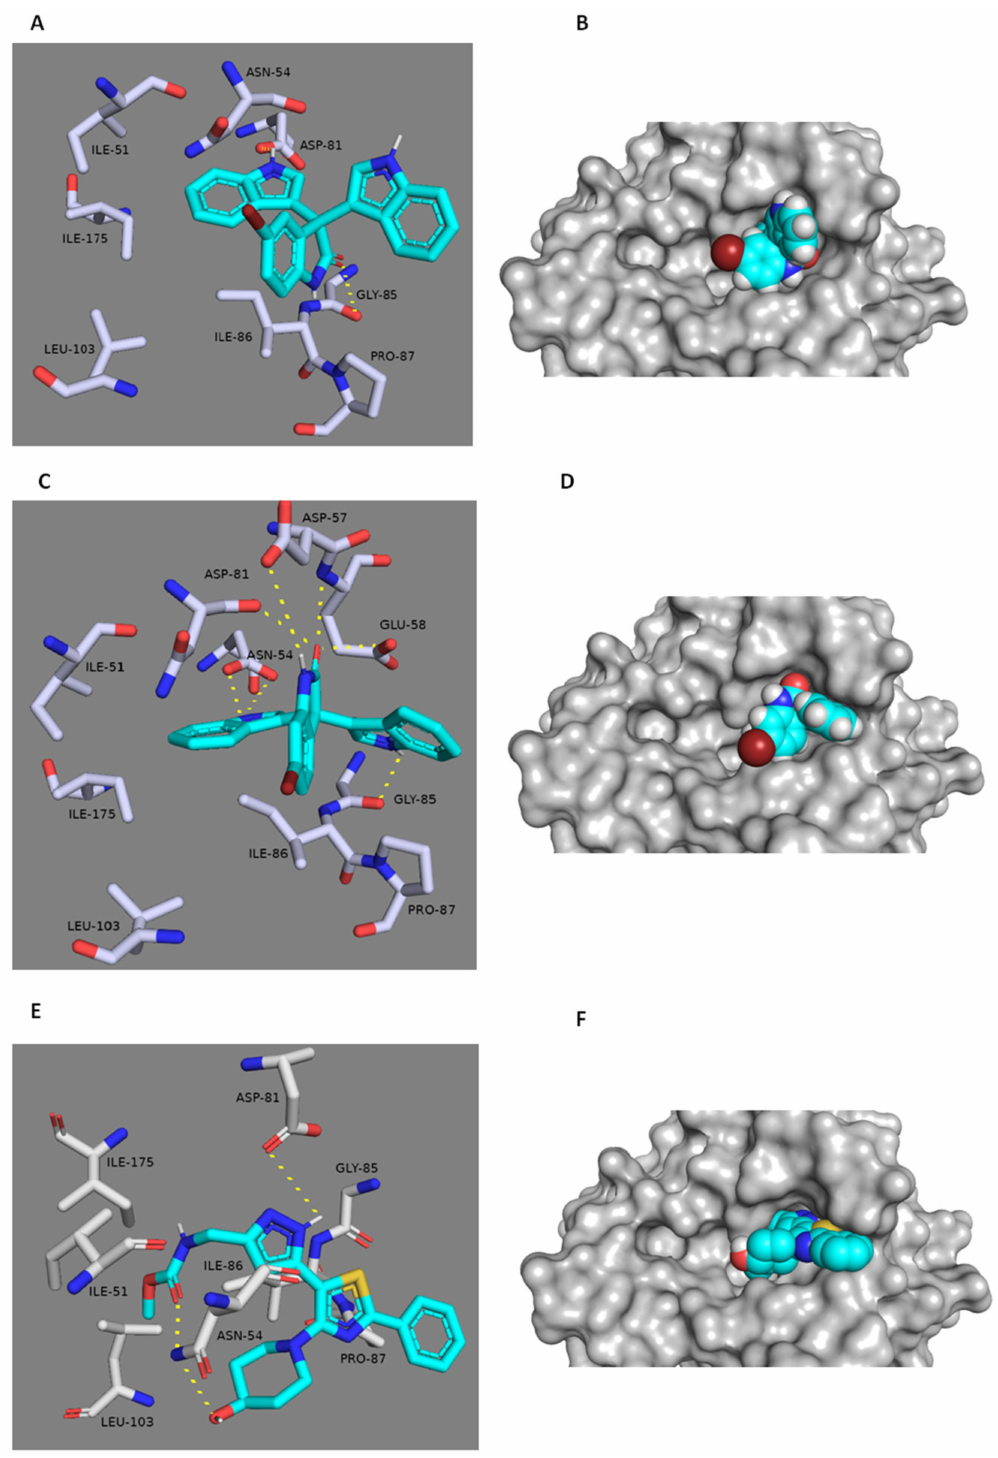
Figure 5. Docking study of 5-Tris ( A , B ) and 6-Tris ( C , D ) within the active site of multidrug-resistant Staphylococcus aureus (MRSA) Gyr-B. The key binding interactions of the Gyr-B co-crystallized ligand [29] are shown in ( E , F ). The amino acid side chains are depicted in ( A , C , E ) for